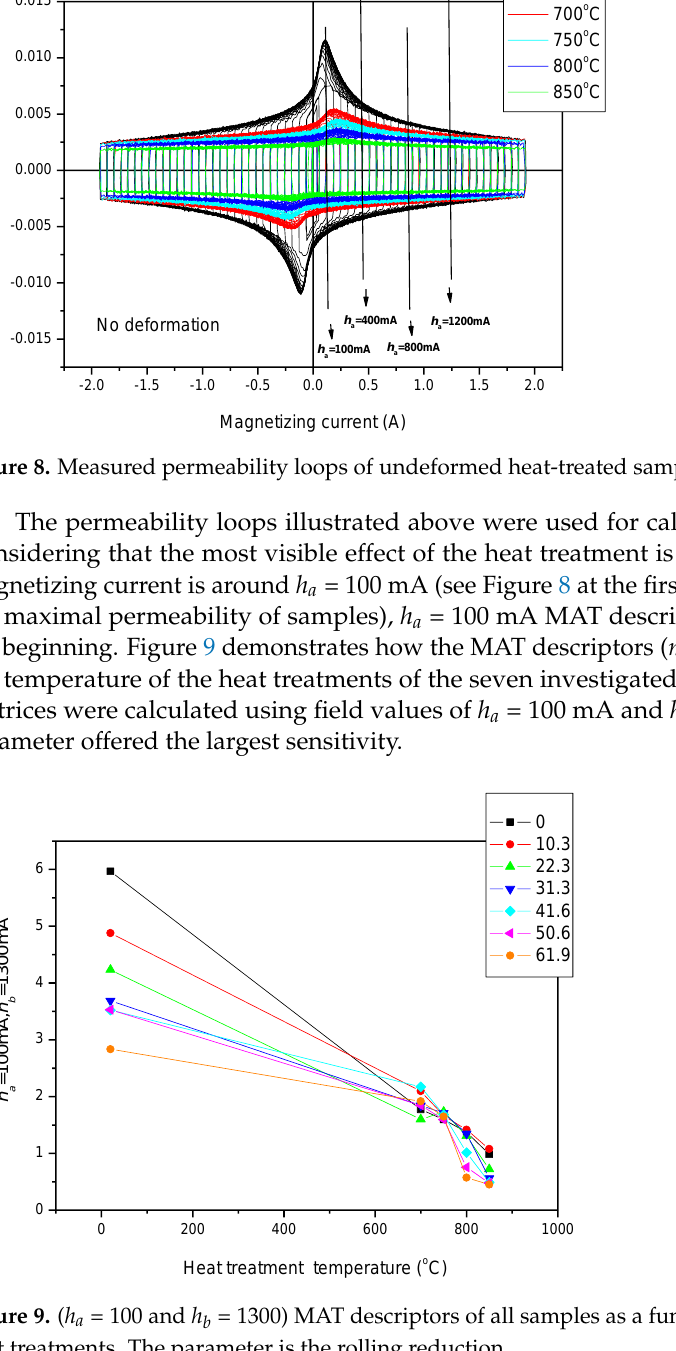
that shown in Figure